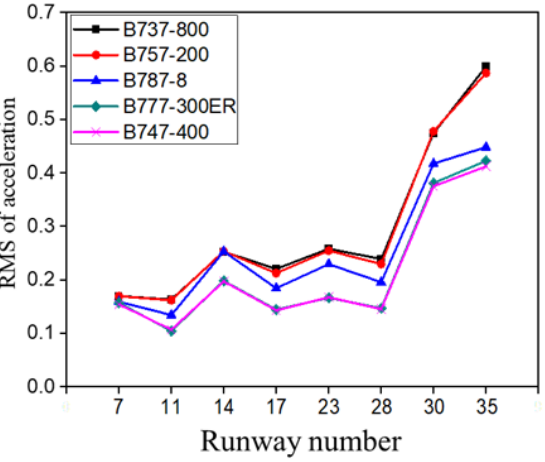
Figure 5. Comparison of results obtained from five aircraft